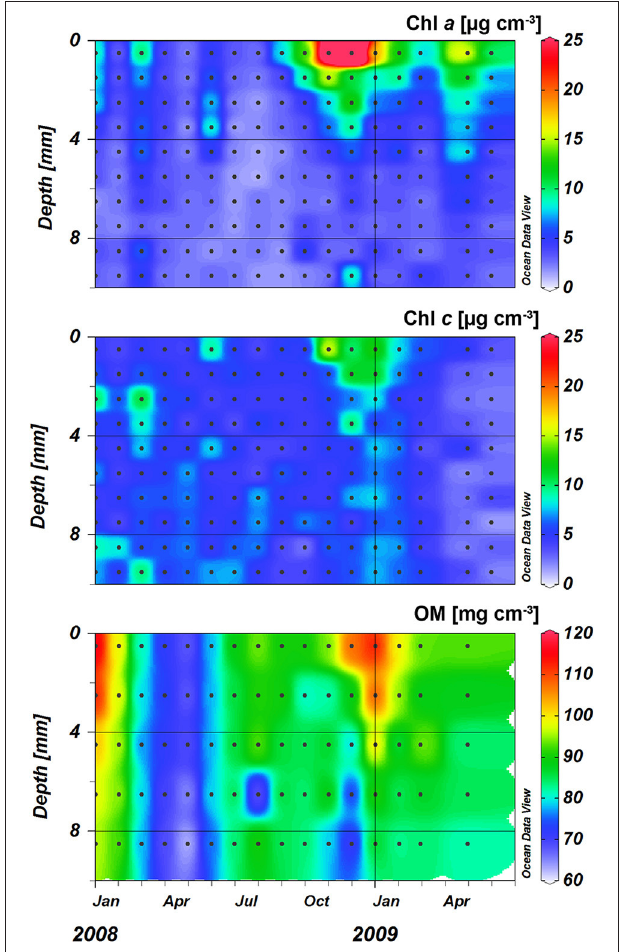
FIGURE 5 | Chlorophyll a (Chl a ), chlorophyll c (Chl c ), and organic matter (OM) profiles at the sampling station on Trocadero Island, Bay of Cádiz, from January 2008 to June 2009. Data are mean of 3 sediment